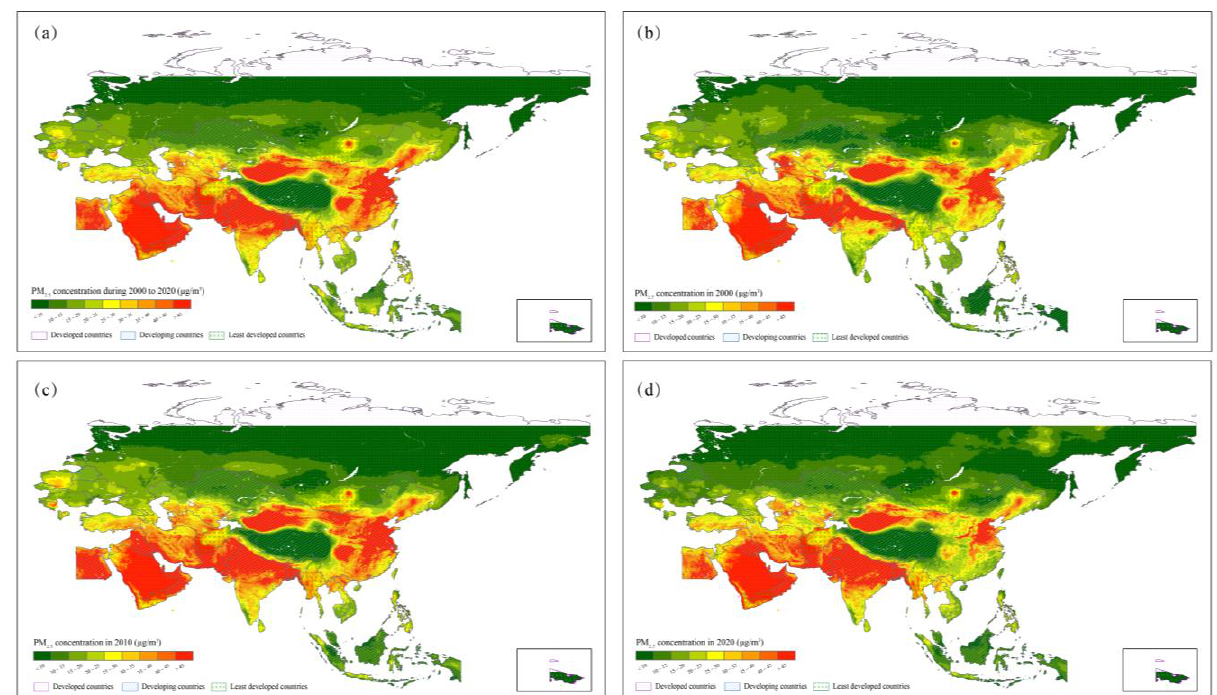
Figure 4. Spatial distribution of annual mean PM 2.5 concentrations in B&R region in the year of ( a ) 2000 to 2020, ( b ) 2000, ( c ) 2010, ( d ) 2020.